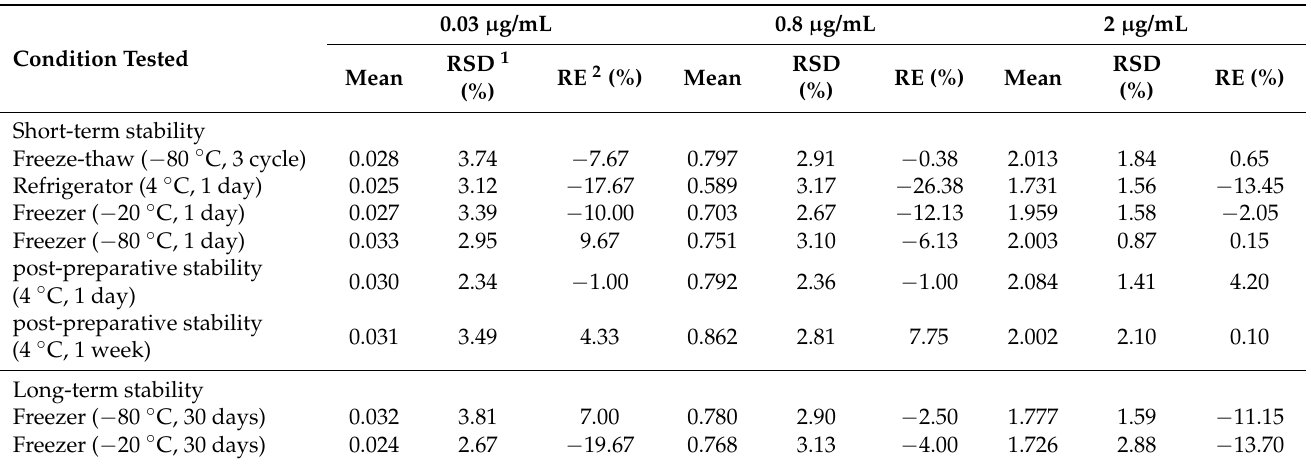
Table 4. Stability test for SFN in rat